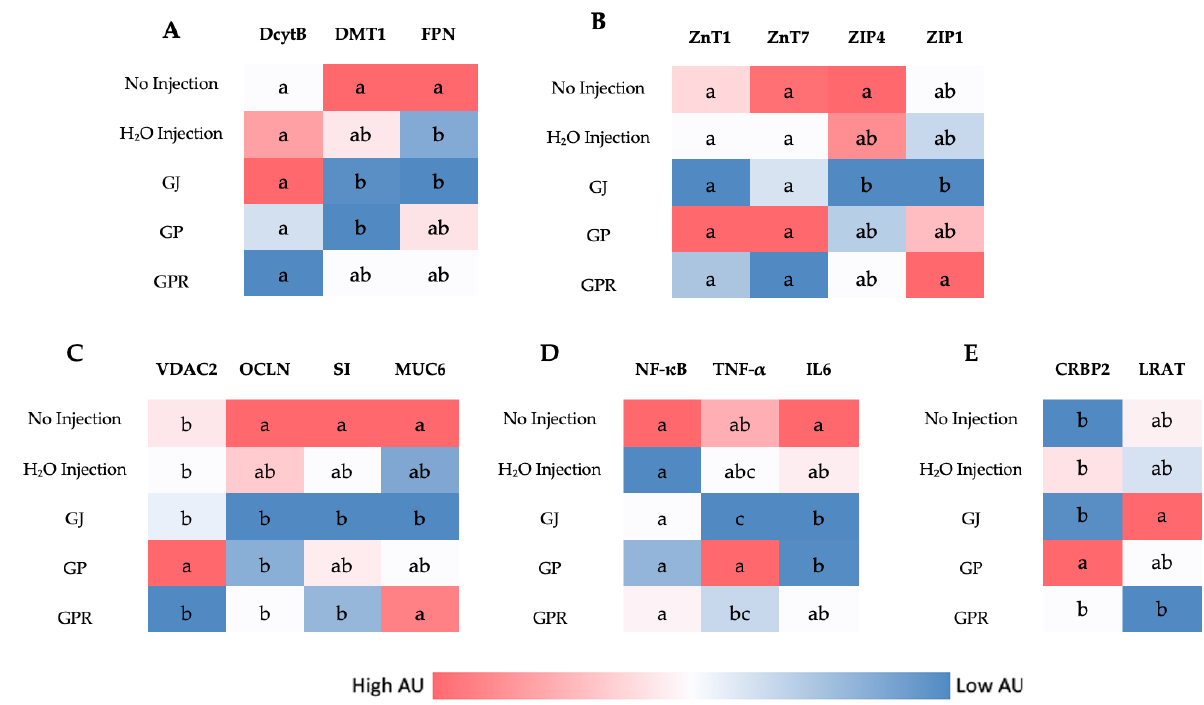
Figure 2. Heatmap showing the effect of intra-amniotic administration of grape juice (GJ), pomace (GP), and puree (GPR) on duodenal gene expression. ( A )—iron metabolism-related genes, ( B )—zinc metabolism-related genes, ( C )—brush border membrane functionality genes, ( D )—genes coding for inflammatory cytokines and ( E )—Vitamin A metabolism-related genes. Values are in arbitrary units (AU). Genes not indicated by the same letter (a,b,c) are significantly different ( p < 0.05). Key; Iron metabolism (DMT1: Divalent metal transporter 1; DcytB: Duodenal cytochrome b), Zinc metabolism (ZIP: Zrt-, Irt-like proteins; ZnT: zinc transporter), Vitamin A metabolism (CRBP2: Cellular retinol-binding protein; LRAT: Lecithin retinol acyltransferase), inflammatory cytokines (NF- κB: Nuclear factor-kappa beta; IL6: Interleukin 6; TNF- α: Tumor Necrosis Factor Alpha), Brush border membrane functionality (VDAC: Voltage-dependent anion channel; SI: Sucrose isomaltase; OCLN: Occludin; MUC6: Mucin).